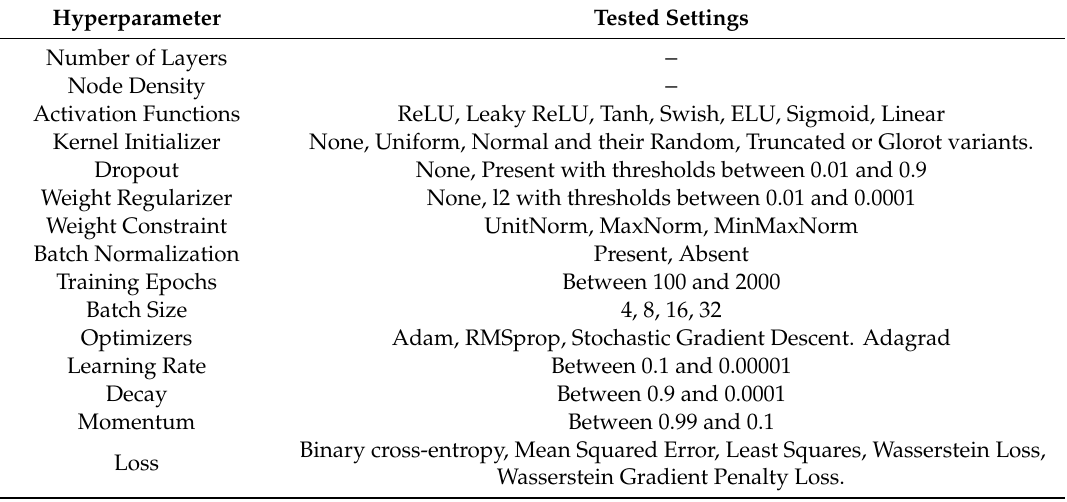
Table 1. List of hyperparameters and settings tested during optimization of GAN model